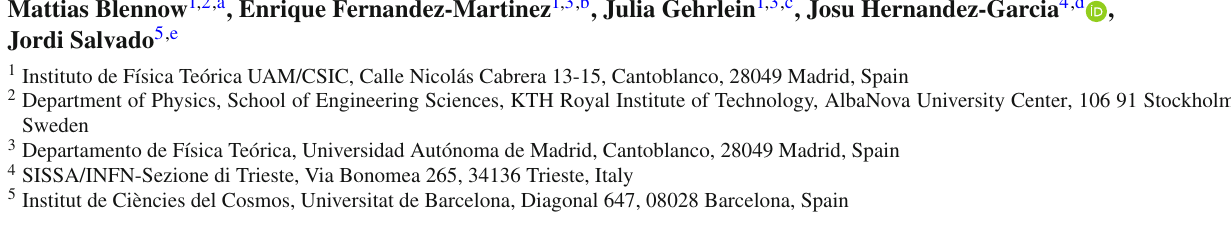
Table 1 for recent global fit results of the mass and